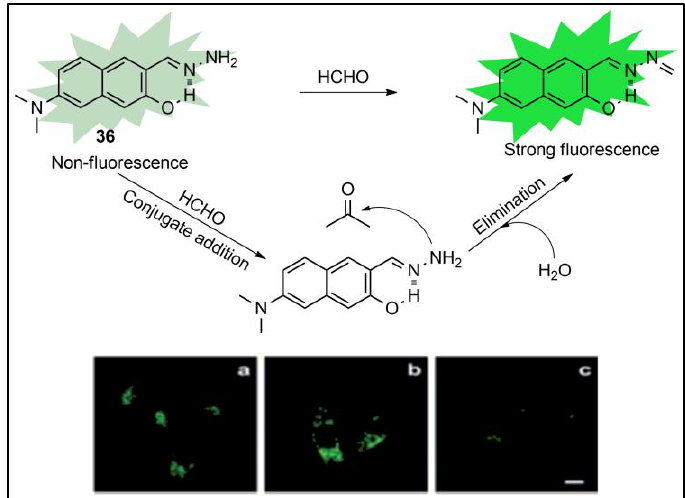
Figure 36. Structure of probe 36 and its mechanism of the reaction to formaldehyde. Confocal microscopy images ( a – c )—endogenous, exogenous, and inhibitory experiments of formaldehyde in HeLa cells. Adapted with permission from [116]. Copyright (2019) The Royal Society of Chemistry.